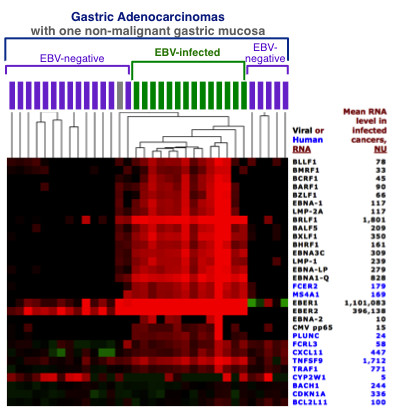
 Latent and lytic EBV genes are co-expressed in gastric cancer. A portion of the heat map from Figure
1 is displayed in high contrast to decipher relative expression levels of EBV genes in the 14 EBV-infected gastric cancers and surrounding specimens. All tissues are gastric cancers except a single non-malignant gastric mucosa, shown in grey, dissected from the same paraffin block as an EBV-infected gastric cancer. Mean expression level of each RNA in the EBV-infected gastric cancer cohort is shown to the right of each gene symbol.